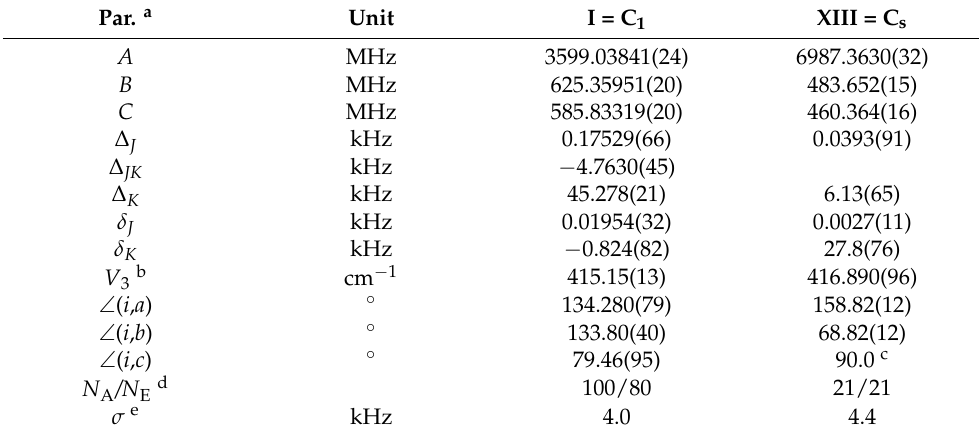
Table 2. Molecular parameters of the two assigned conformers I (C 1 ) and XIII (C s ) of MHO obtained from a fit with the program XIAM